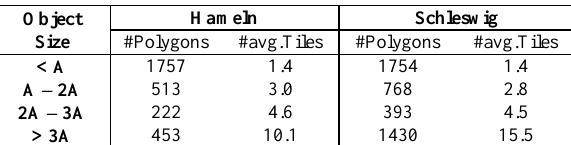
Table 5: Number of polygons (#Polygons) and avegrage tiles (#avg.Tiles) generated in tiling approach as a function of object size in Hameln and